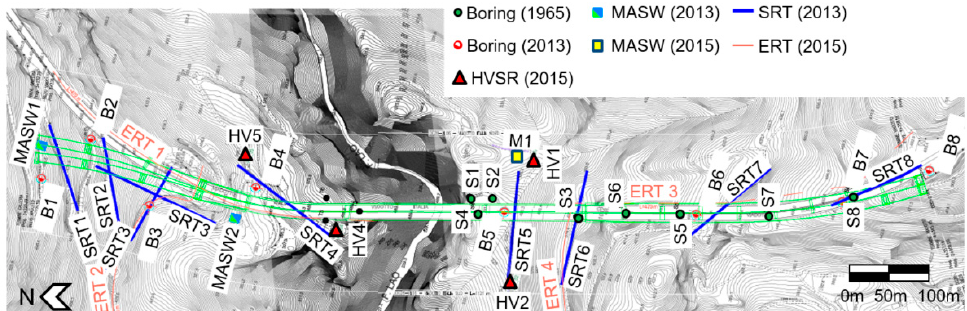
Figure 3. Location of geophysical/geotechnical investigations in the central area of the Viadotto Ita-